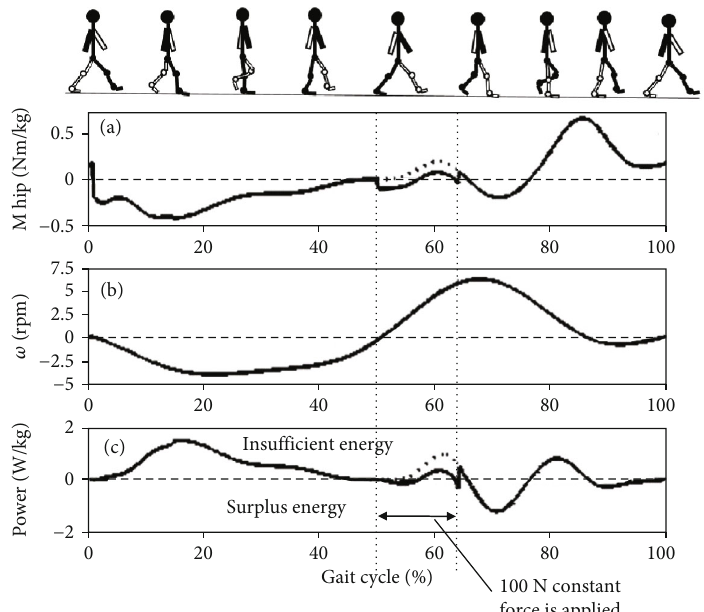
Figure 6: Simulated (a) hip moment, (b) angular velocity of the hip joint, and (c) mechanical power during a walking gait cycle. Here, the solid and dotted lines represent the cases in which the soft exoskeleton is not worn and worn, respectively. A constant assistive force was applied during the preswing phase for conserving power.